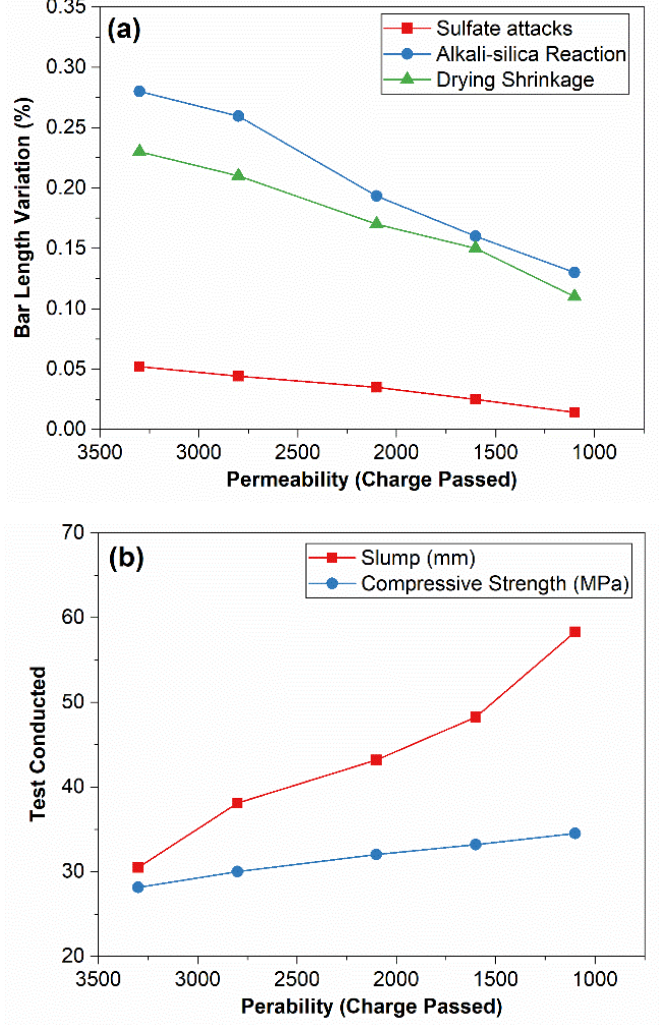
Figure 7. Interrelation between Chloride Permeability and ( a ) Durability Issues ( b ) Slump and Compressive Strength.